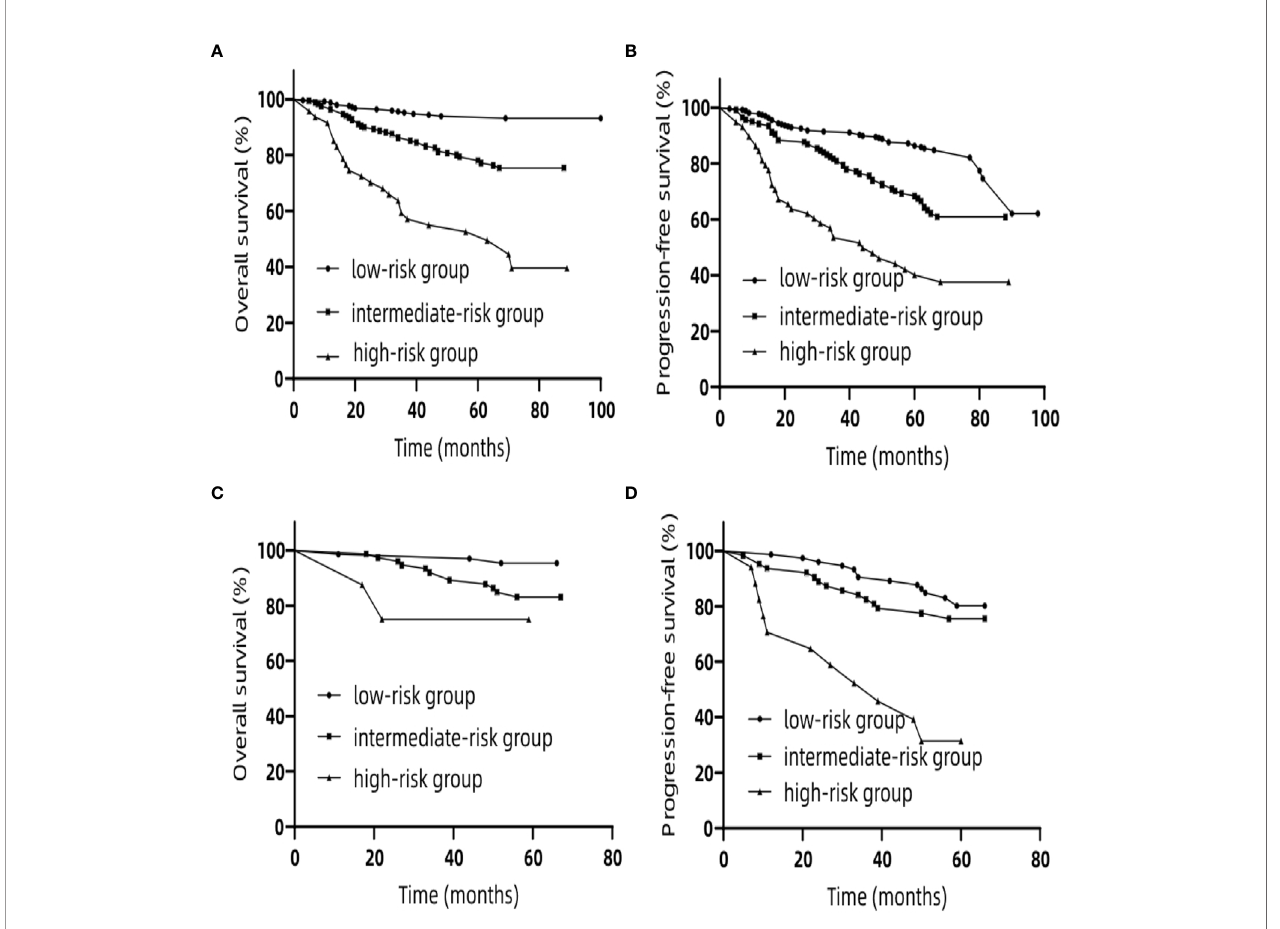
FIGURE 6 | Kaplan – Meier curves for risk group strati fi cation for OS (A) and PFS (B) in the training set. Kaplan – Meier curves for risk group strati fi cation for OS (C) and PFS (D) in the validation set. OS, overall survival; PFS, progression-free